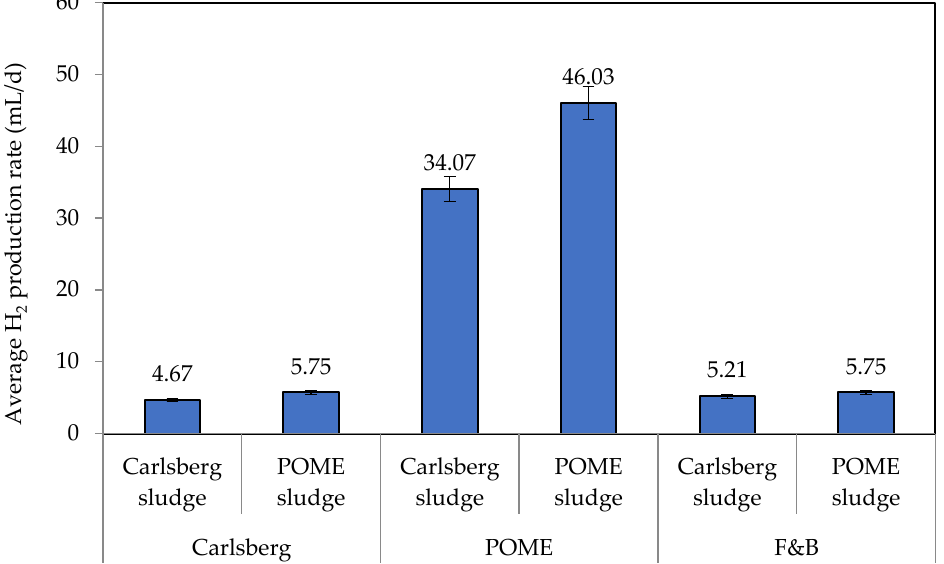
Figure 5. Biohydrogen produced by inoculum is derived from different sludges grown in various wastewater media (substrate) with Carlsberg = 12.5 g COD/L, POME = 13 g COD/L, and F&B = 2.5 g COD/L. The media were adjusted to pH 5.5. Experiments were done in triplicates ( n = 3), and samples were taken at 24 h.